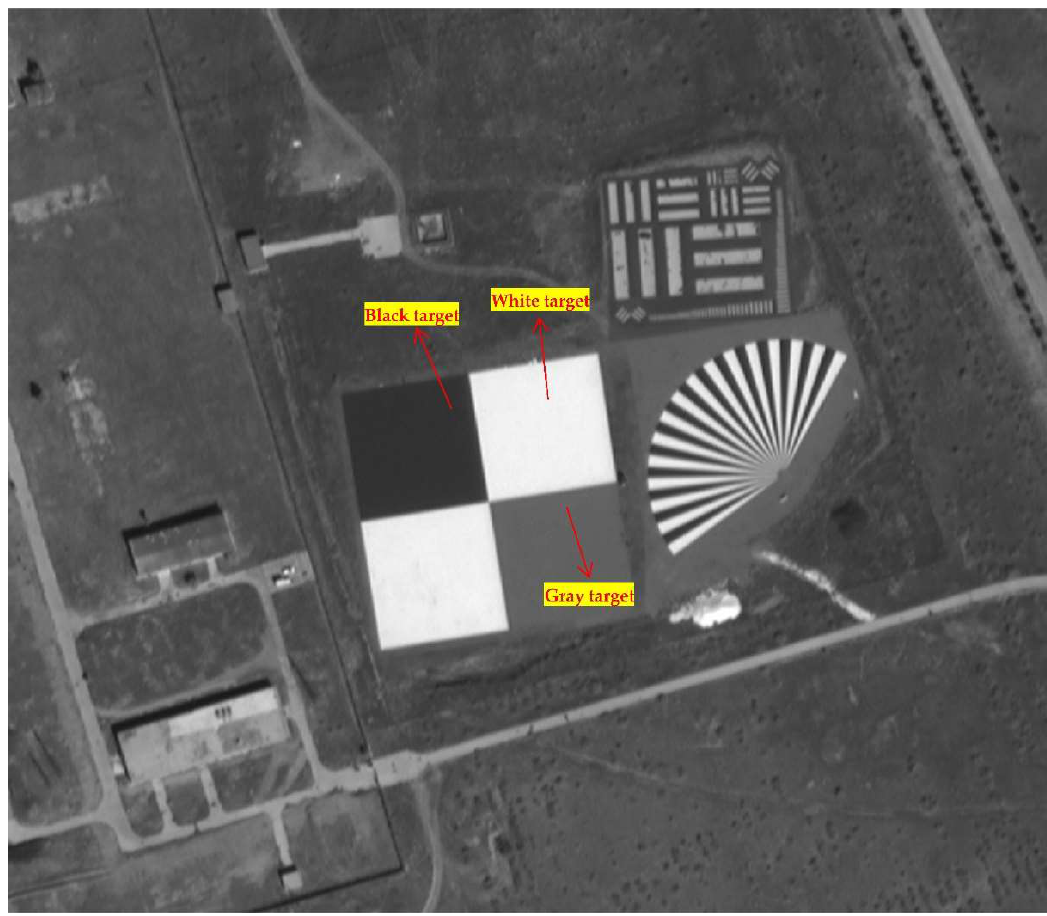
Figure 7. The gray-scale permanent artificial targets at the Baotou site of GF-7 BWD imagery (15 September 2020).